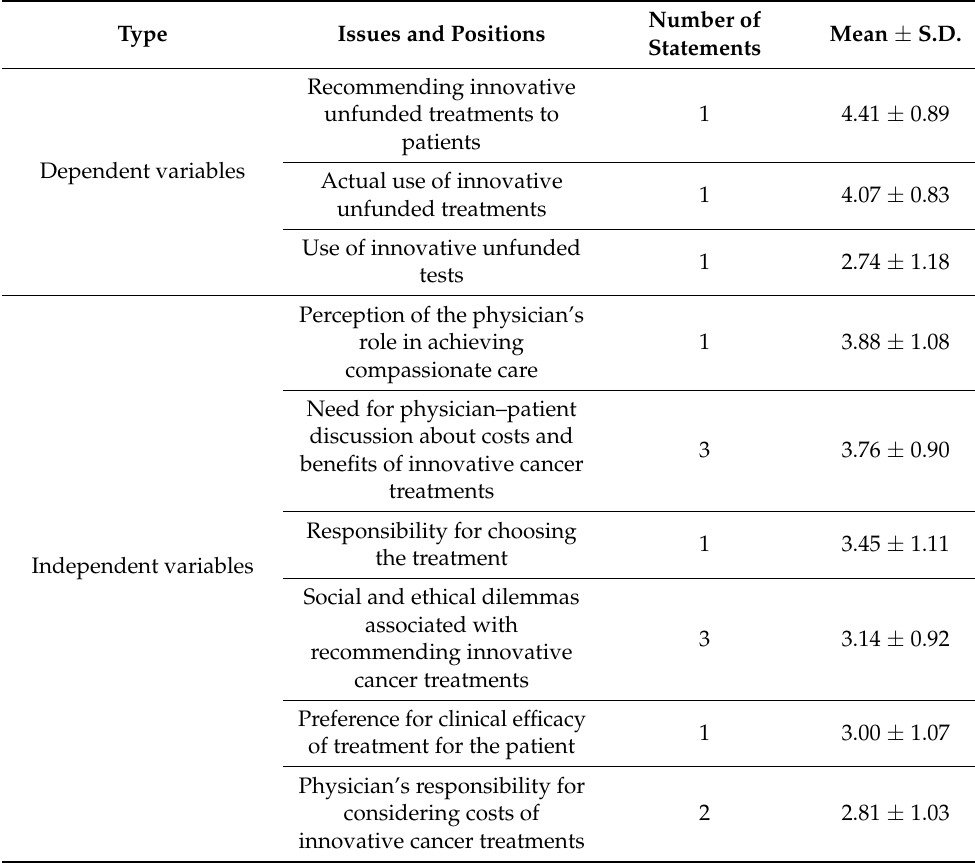
Table 1. Research variable means and standard